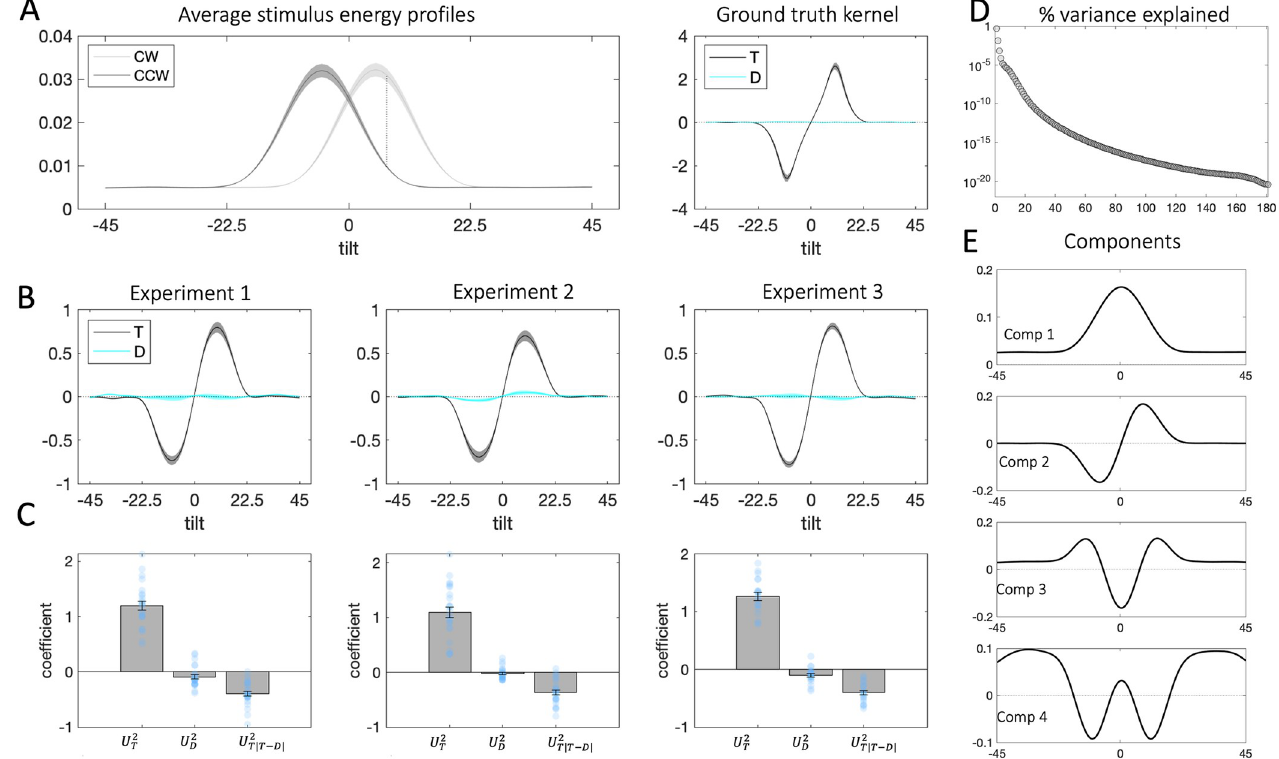
Fig 3. A. Left : Average stimulus energy profiles (CCW = dark grey, CW = light grey; shaded regions correspond to M ± SEM; the dashed line denotes maximum signal-to-noise ratio). Right : Decision kernel based on ground truth stimulus tilts (target stimulus = black, distracter = cyan; shaded regions correspond to M ± SEM, Exp.1). B : Decision kernel based on participant choices (target stimulus = black, distracter = cyan; shaded regions correspond to M ± SEM). C. Beta coefficients from a binomial regression of participant choices on stimulus scores for the second component and interactions with distracter signals. D. Percentage of variance in the stimulus energy profile explained by each of the singular value decomposition (SVD) components. Note that the y axis is in logarithmic scale. E. Illustration of the first four components, which together explain 96% of the variance in stimulus energy profiles.